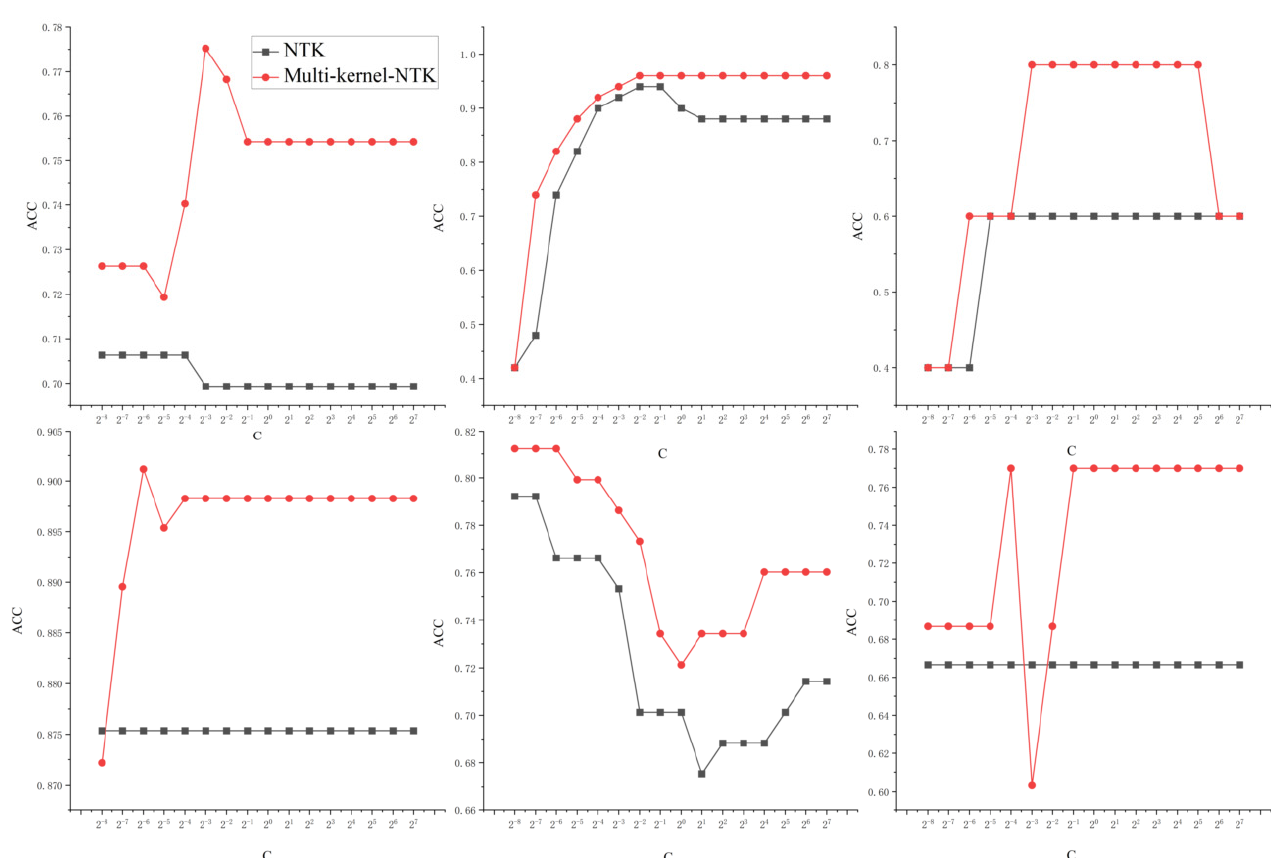
Figure 5. Effect of penalty parameter C on the accuracy of the model. The red line represents the trend of the multi-kernel-NTK model with C, and the black line represents the trend of the original NTK model with C.